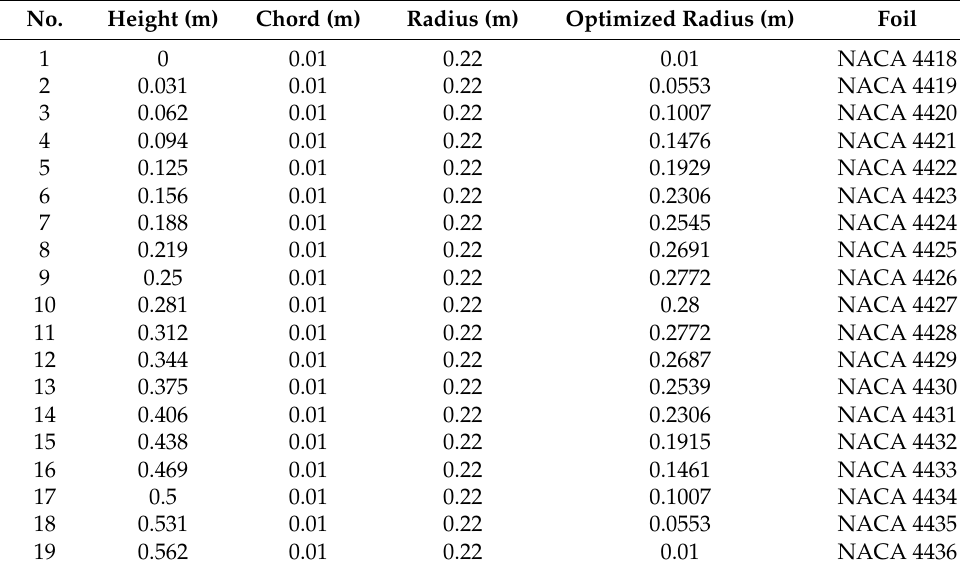
Table 2. Vertical axis wind blade profile design for different sections of the blade.